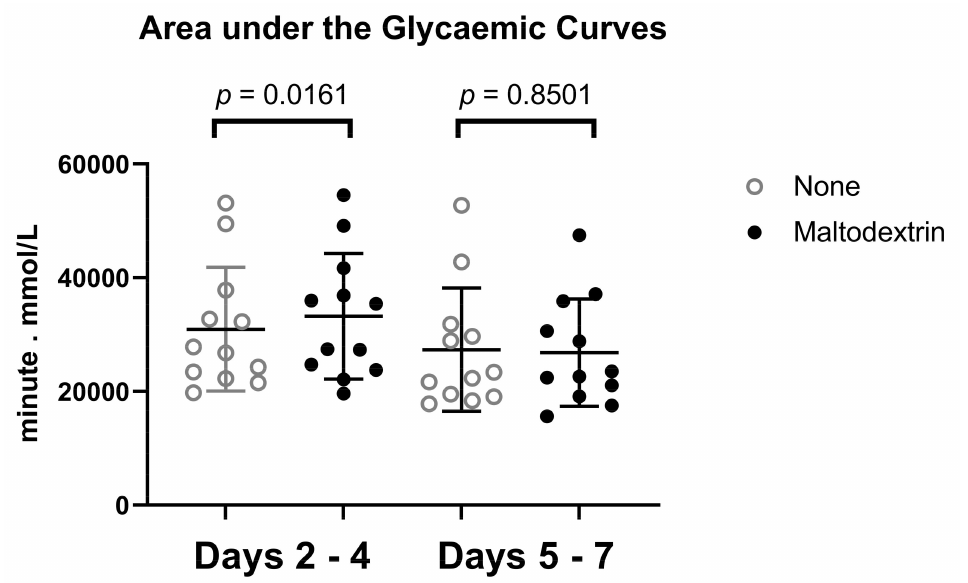
Figure 3. Area under the glycemic curves. A comparison of areas under the glycemic curves: the patients receiving maltodextrin had significantly higher area under the curve during days 2–4 ( p = 0.0161). This difference was absent during days 5–7 ( p = 0.8501).